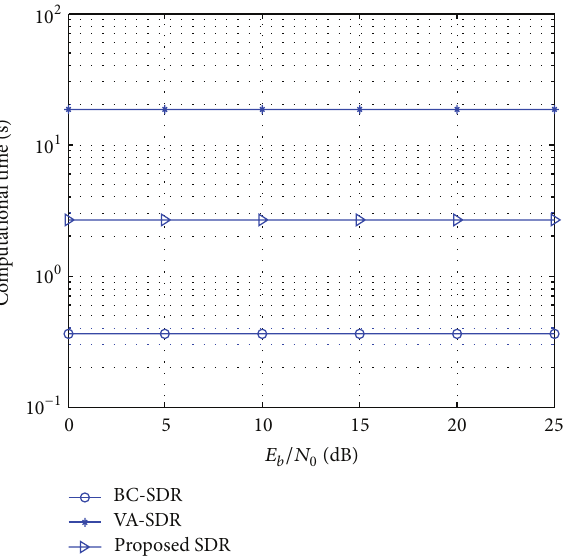
Figure 4: The computational time of the SDR detectors for 8 × 8 256-QAM MIMO